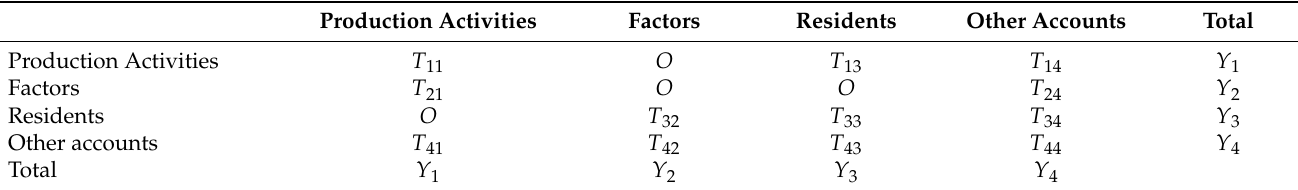
Table 2. The Simplified macro-SAM. Production Activities Factors Residents Other Accounts Total Production Activities T 11 O Y 1 Factors Y 2 Residents O T